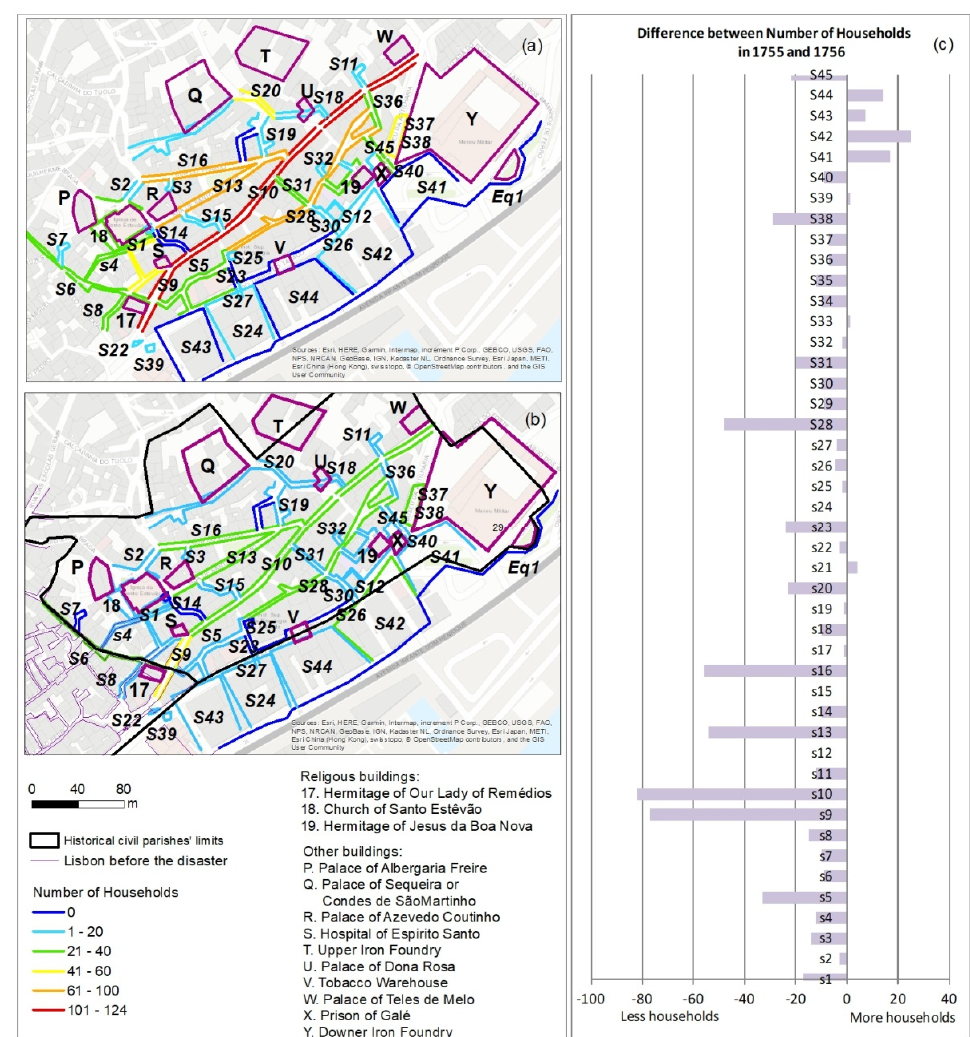
Figure 4. Number of households on each street in the historical civil parish of Santo Estev ã o ( a ) in 1755; ( b ) in 1756; ( c ) graph with the difference of the households. Street names, land uses and equipment: S1. Forecourt of Church of Santo Estev ã o; S2. Street of Nova do Almeida; S3. Arch of Chanceler; S4. Alley of Carneiro; S5. Sidewalk of Santo Estev ã o; S6. Street of Regueira; S7. Alfugera; S8. Alley of Esp í rito Santo; S9. Street of Rem é dios/Street Direita; S10. Street Direita das Portas da Cruz; S11. Alley of Fr ó is; S12. Courtyard of P ó lvora; S13. Street Direita de Santo Estev ã o; S14. Square of Santo Estev ã o; S15. Alley of Maria da Guerra; S16. Street of Vig á rio; S17. Alley of Loureiro; S18. Outeiro de Baixo; S19. Alley of Paus; S20. Outeiro de Cima; S21. Outeiro da amendoeira; S22. Alpendres; S23. Alley of Banebuquel; S24. Beach; S25. Courtyard of Mello; S26. Alley of Estanco; S27. Alley of Cancela; S28. Street of Lapa; S29. Alley of Muro; S30. Alley of Maquinez; S31. Alley of Ramos; S32. Alley of Mil Patacas; S33. Alley of Furtado; S34. Square of Br á s; S35. Alley of Rec â mara; S36. Alley of Surra; S37. Alley that goes to Goleta; S38. Alley of Goleta; S39. Peitoril; S40. Marketplace Doors; S41. Beach of Casas; S42. Beach of Gal é ; S43. Beach of Pipas; S44. Beach of Estanque; S45. Alley of Belo; Eq1. Pier of the Downer Iron Foundry. The present-day layout of the city is presented on the